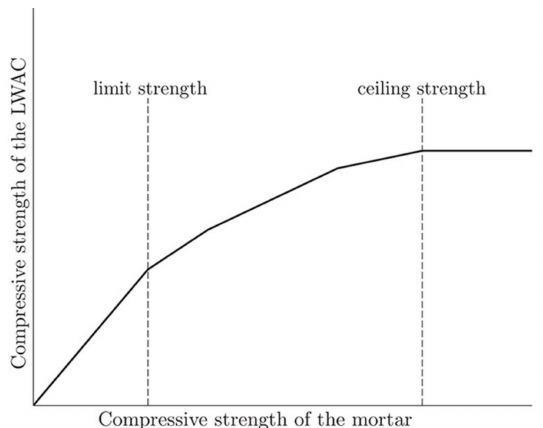
Figure 9. Relationship between the strength of the mortar and of light weight aggregate concrete (LWAC) made with the same mortar [70], with copyright permission from